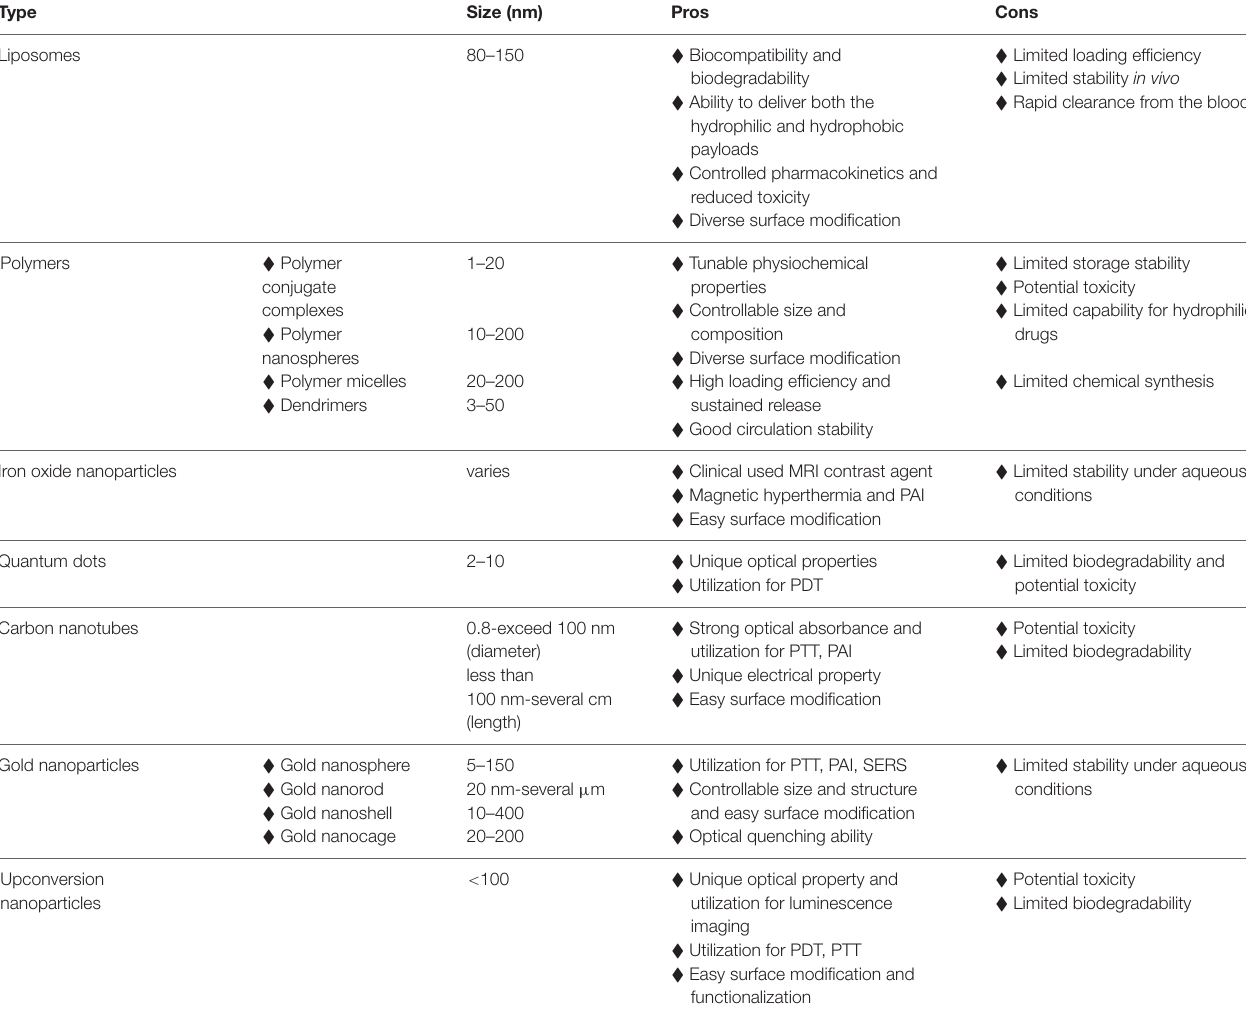
TABLE 1 | Representative theranostic nanomaterials utilized in drug delivery system.